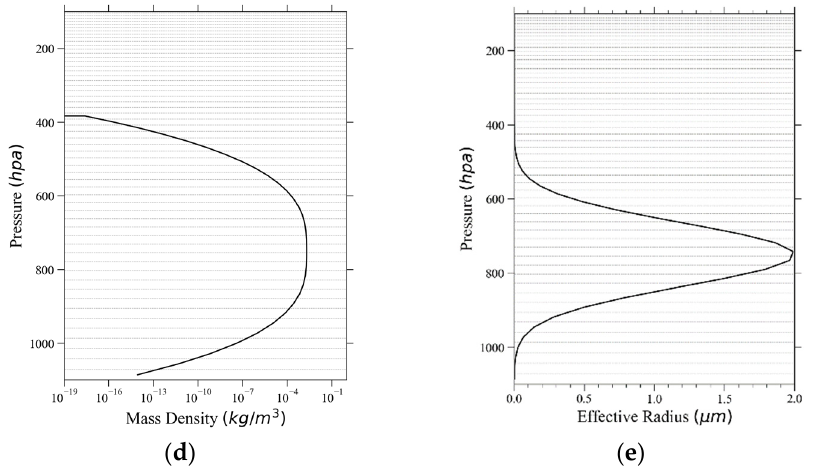
Figure 1. The vertical distributions of the atmospheric profiles: ( a ) temperature, ( b ) specific humidity, ( c ) ozone, ( d ) aerosol concentration, ( e ) aerosol effective radius.